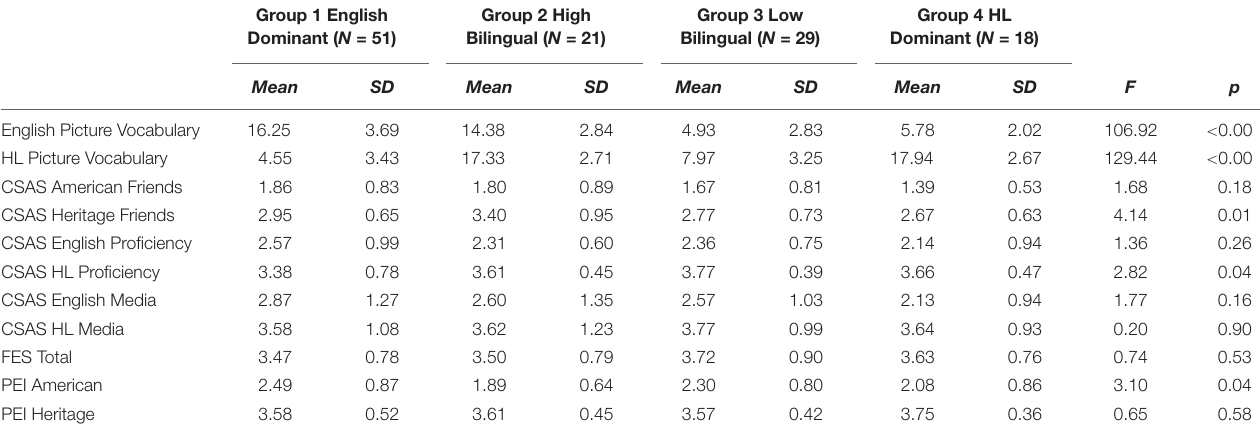
TABLE 6 | Child oral language achievement scores by